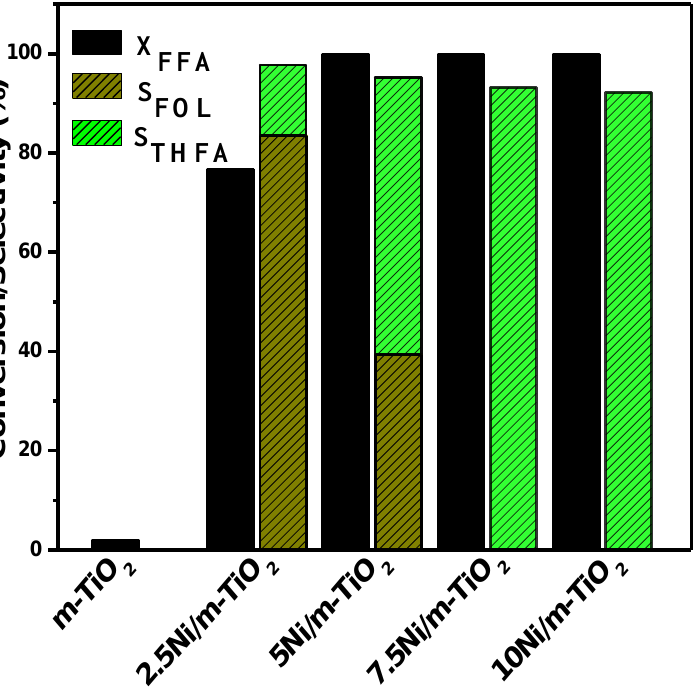
Figure 7. Furfural hydrogenation over xNi/m-TiO 2 catalysts. Reaction conditions: 0.030 g catalyst, 1 mmol furfural, 2 mL water, 2 MPa H 2 , 100 °C, and 4 h.